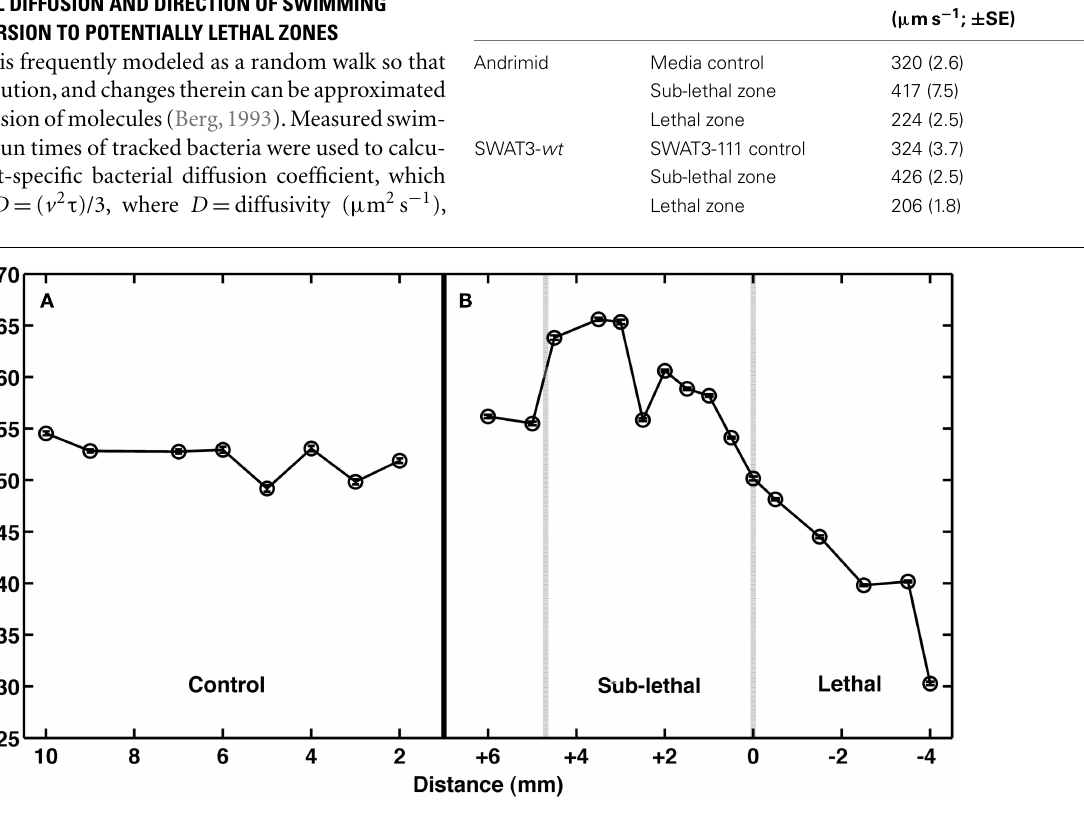
FIGURE 3 | Impact of andrimid on Vibrio cholerae swimming speed. Mean swimming speeds of V. cholerae at distances (A) from a colony of SWAT3-111 (control) and (B) inside the sub-lethal ( + ) and lethal ( − ) zones where 0mm indicates the delineation of the zone of growth inhibition created